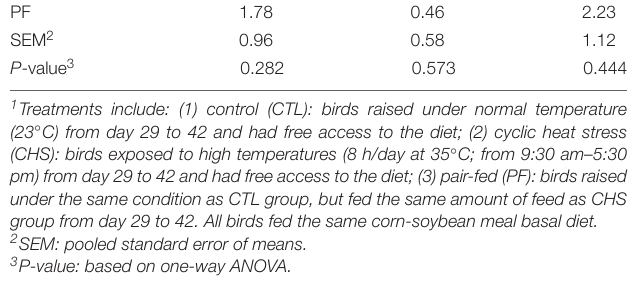
TABLE 5 | Effect of rearing temperature and feed restriction on carcass and meat yield of Cobb 500 male broiler chickens on day 42. 1 Treatments 2 Hot carcass Meat yield (% hot carcass (% body weight)